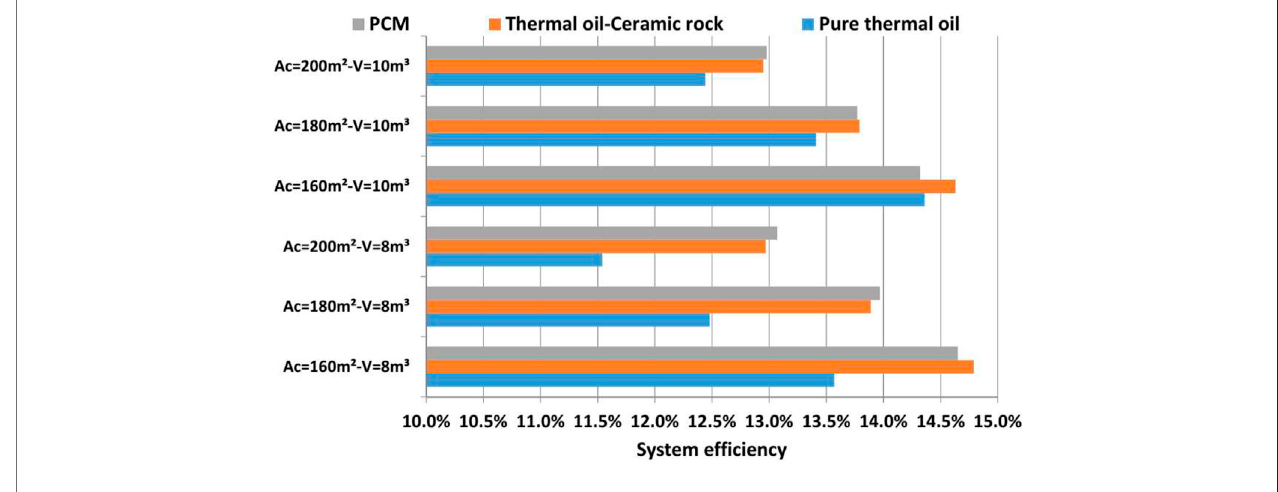
FIGURE 4 | Ef fi ciency of the system in different collecting areas (Bellos et al., 2020).